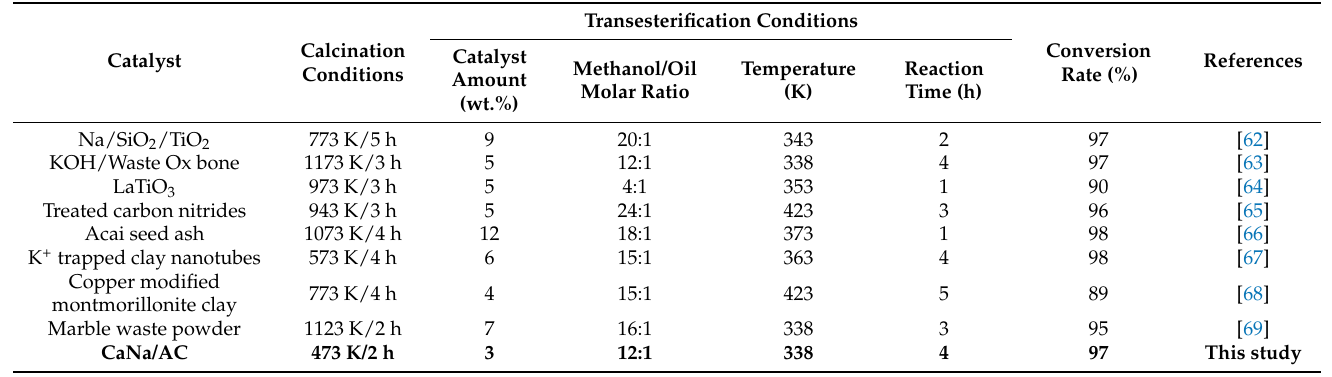
Table 4. Comparison of capacities of heterogeneous catalysts for biodiesel